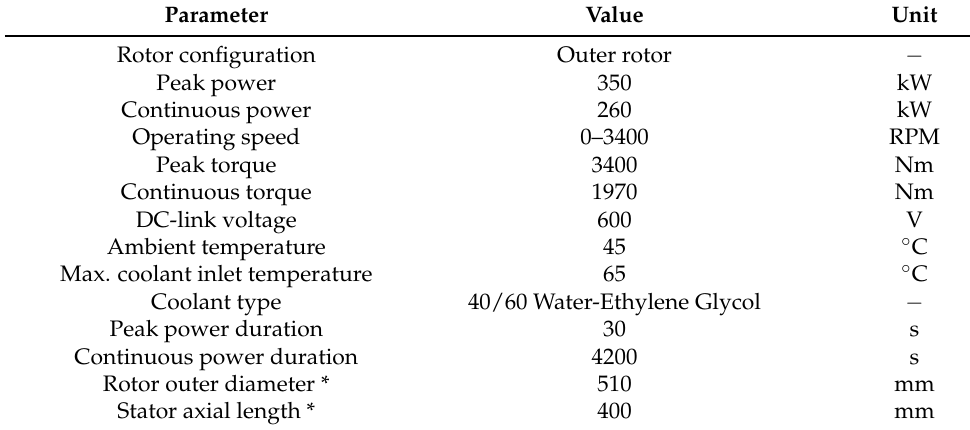
Table 3. SRM design